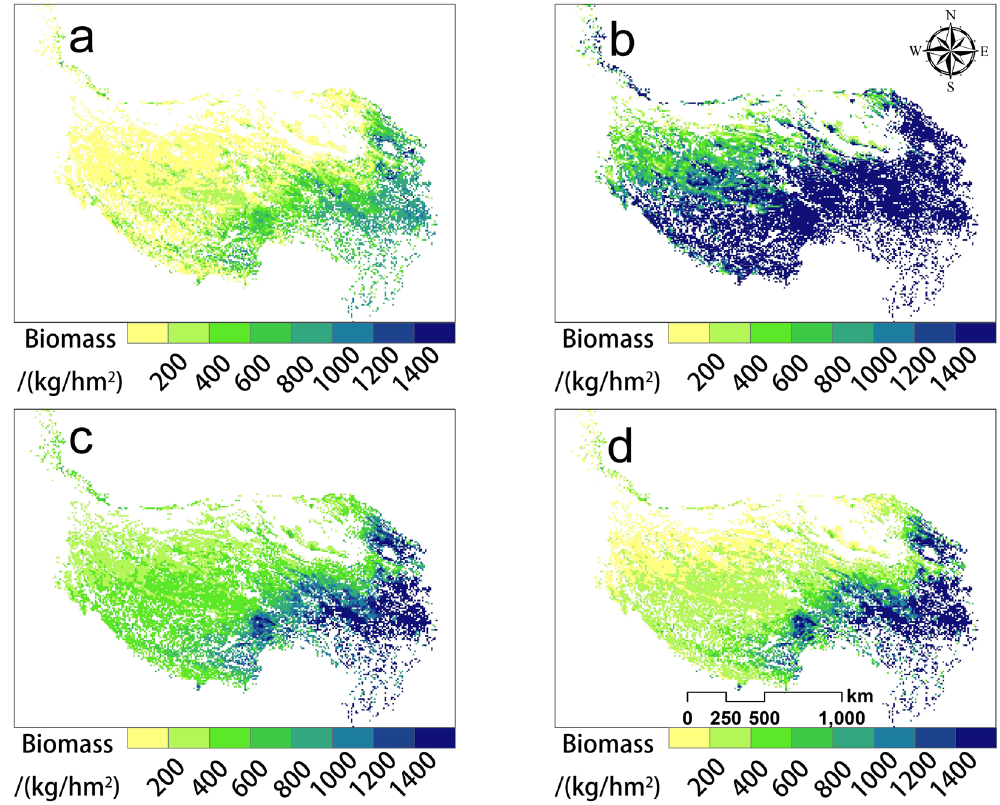
Figure 6. Spatial distribution of the mean aboveground biomass from 2000 to 2012 in the grasslands of the Qinghai-Tibet Plateau by different MODIS NDVI-AGB models. ( a ) Estimated by models of this study, ( b ) by Fang et al . 39 , ( c ) by Feng et al . 40 , and ( d ) by Chu et al . 41 . The map was edited and generated with ArcGIS 10.2.2,